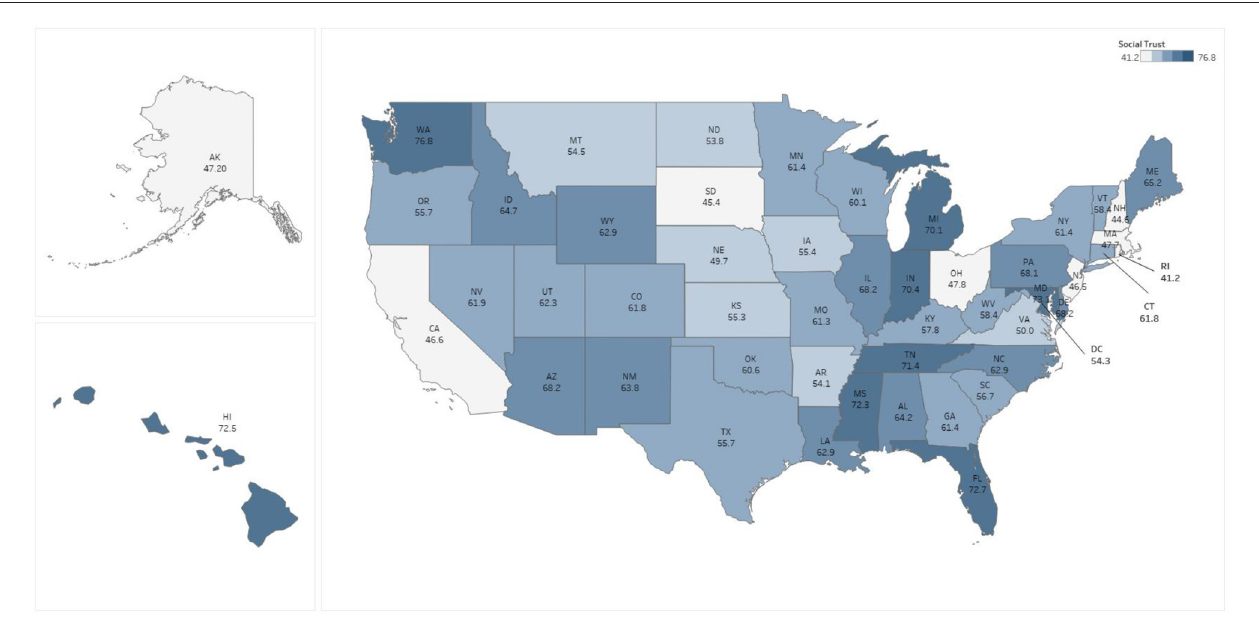
FIGURE 3 | Pre-pandemic social trust by